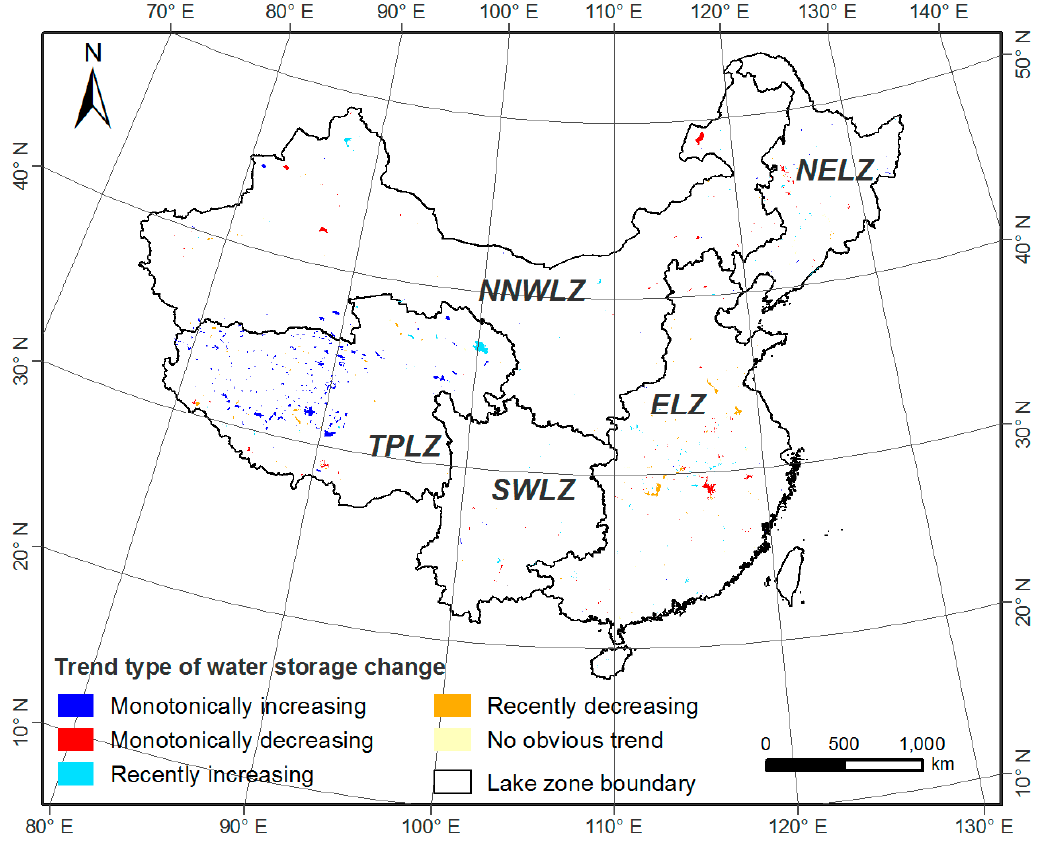
Figure 7. Spatial distribution of the five temporal trend types of water storage change ( ∆V ) in lakes and reservoirs across China, 1984–2015 (N= 760).